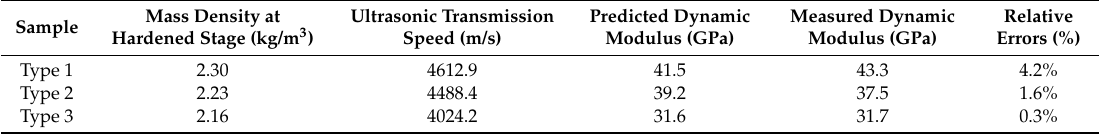
Table 4. Properties of concrete samples during the early stages